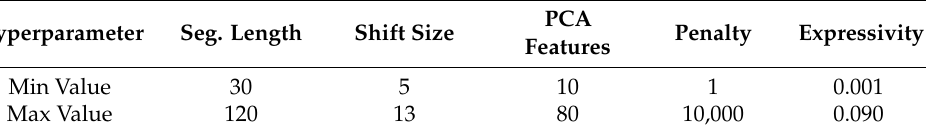
Table 4. Value range of hyperparameters